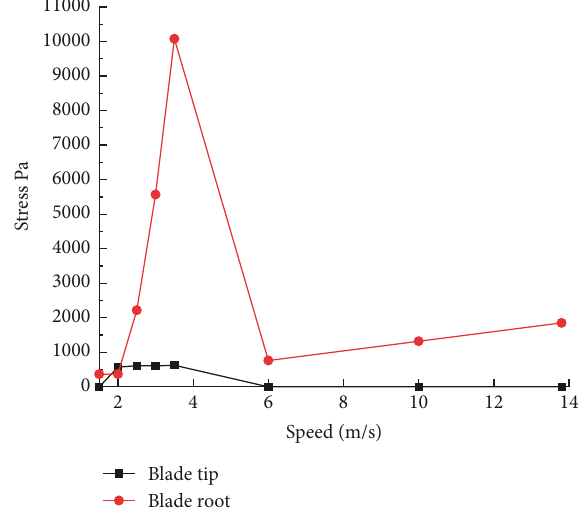
Figure 4: Stress value curve of the blade tip and blade root.